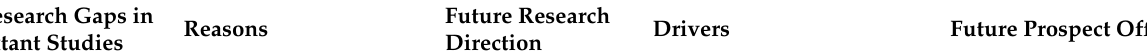
Table 5. Future Research